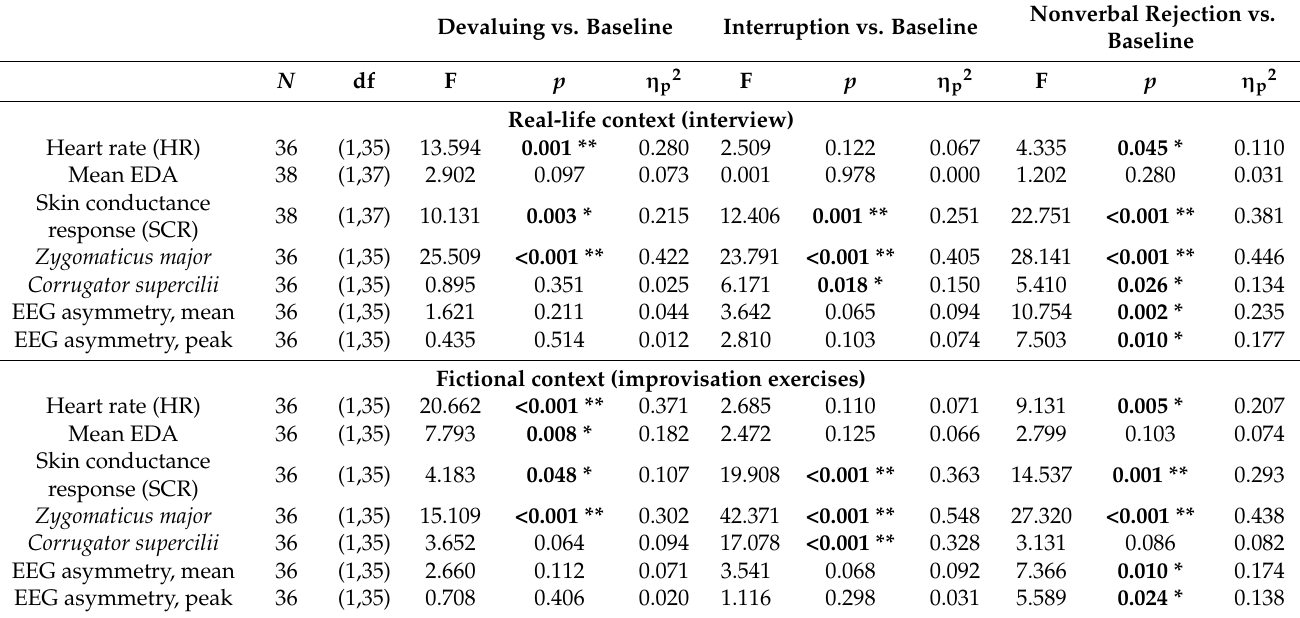
Table 1. Differences between Baseline and Social Rejection Responses.